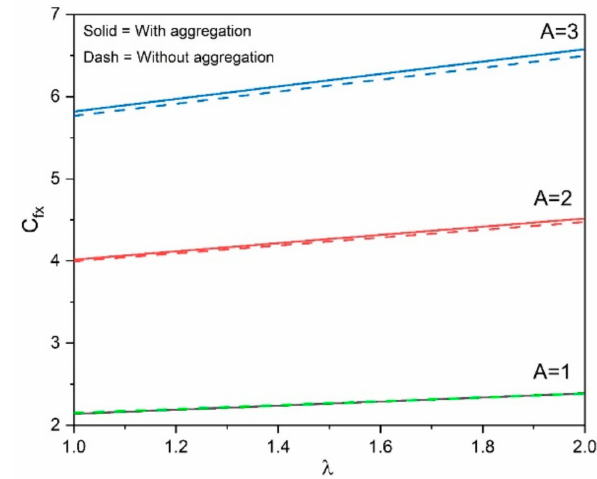
Figure 9. Influence of C fx on λ for numerous values of A .